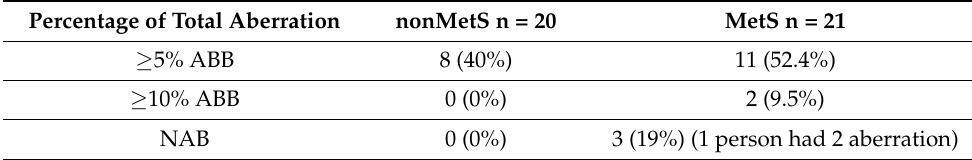
Table 4. Individual analysis, number of persons with